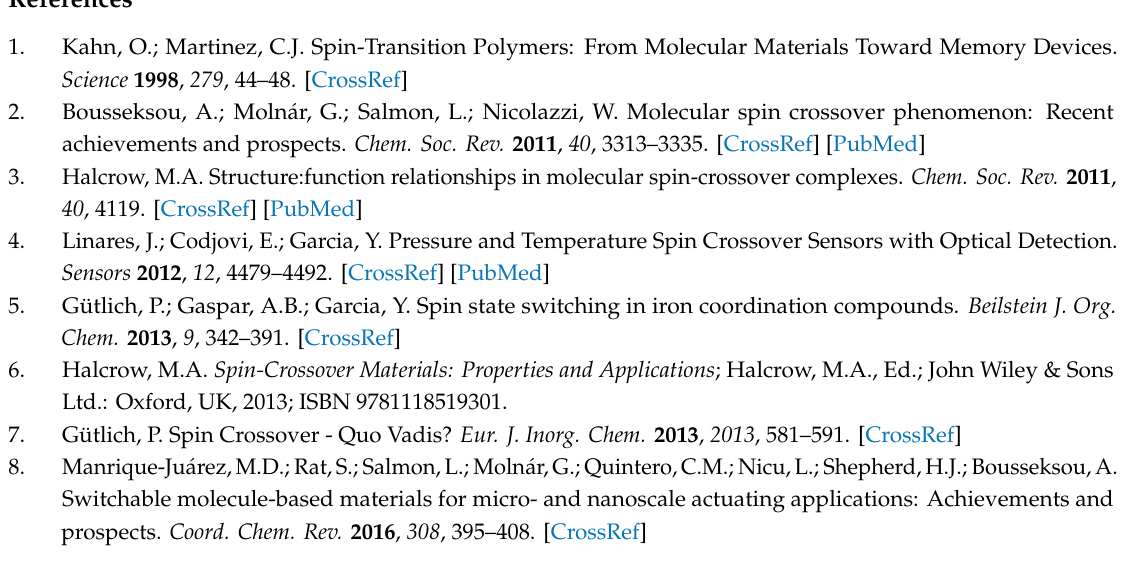
Figure S1. 1 H-NMR of 2,5-bis{[(1 H -imidazol-4-ylmethyl)amino]methyl}-1,3,4-thiadiazole ( I 4 MTD ). Figure S2. 13 C-NMR of 2,5-bis{[(1 H -imidazol-4-ylmethyl)amino]methyl}-1,3,4-thiadiazole ( I 4 MTD ). Figure S3. Field desorption mass spectrum of 2,5-bis{[(1 H -imidazol-4-ylmethyl)amino]methyl}-1,3,4-thiadiazole ( I 4 MTD ). Figure S4 . IR spectrum of air-dried [Fe II 2 ( I 4 MTD ) 2 ](F 3 CSO 3 ) 4 ( C1 ). Figure S5 . IR spectrum of air-dried [Fe II 2 ( I 4 MTD ) 2 ](ClO 4 ) 4 ( C2 ). Figure S6 . IR spectrum of air-dried [Fe II 2 ( I 4 MTD ) 2 ](BF 4 ) 4 ( C3 ). Figure S7 . Molecular structure of [Fe II 2 ( I 4 MTD ) 2 ](F 3 CSO 3 ) 4 @solvents ( C1 @solvents) with thermal ellipsoids at 173 K. Solvent molecules could not be solved. Color code: Fe is dark red, N blue, S yellow, C grey, H white, O red and F light green. Figure S8 . Crystal packing and hydrogen bonding (black dashed lines) via anions in [Fe II 2 ( I 4 MTD ) 2 ](F 3 CSO 3 ) 4 @solvents ( C1 @solvents) at 173 K. Non-bridging counter ions have been omitted for clarity. a ) View along crystallographic b -axis. b ) View along crystallographic a -axis. Color code: Fe is dark red, N blue, S yellow, C grey, H white, O red and F light green. Figure S9 . Molecular structure of [Fe II 2 ( I 4 MTD ) 2 ](ClO 4 ) 4 @THF ( C2 @THF) with thermal ellipsoids at 173 K. Color code: Fe is dark red, N blue, S yellow, C grey, H white, O red and Cl green. Figure S10 . Crystal packing and hydrogen bonding (black dashed lines) via anions in [Fe II 2 ( I 4 MTD ) 2 ](ClO 4 ) 4 @THF ( C2 @THF) at 173 K. Non-bridging counter ions and solvent molecules have been omitted for clarity. a ) View along crystallographic a -axis. b ) View along the angle bisector of the crystallographic a - and b -axis. Color code: Fe is dark red, N blue, S yellow, C grey, H white, O red and Cl green. Figure S11 . Molecular structure of [Fe II 2 ( I 4 MTD ) 2 ](BF 4 ) 4 @THF( C3 @THF) with thermal ellipsoids at a ) 200 K and b ) 100 K. Color code: Fe is dark red, N blue, S yellow, C grey, H white, O red, B pink and F light green. Figure S12 . χ M T vs. T data for the air-dried compounds C1 (squares) and C2 (triangles). The data are given per dinuclear iron(II) molecule. Figure S13 . χ M T vs. T data for C3 for a freshly taken sample measured from 10–300 K after direct low-temperature freezing within the magnetometer (filled squares), subsequently measured from 300–10 K (empty squares) and for a dried sample from 10–300 K after heating the sample to 400 K for 2 h (filled circles). The data are given per dinuclear iron(II) molecule. Table S1 . Crystallographic parameters for all discussed crystal structures of C1 – C3